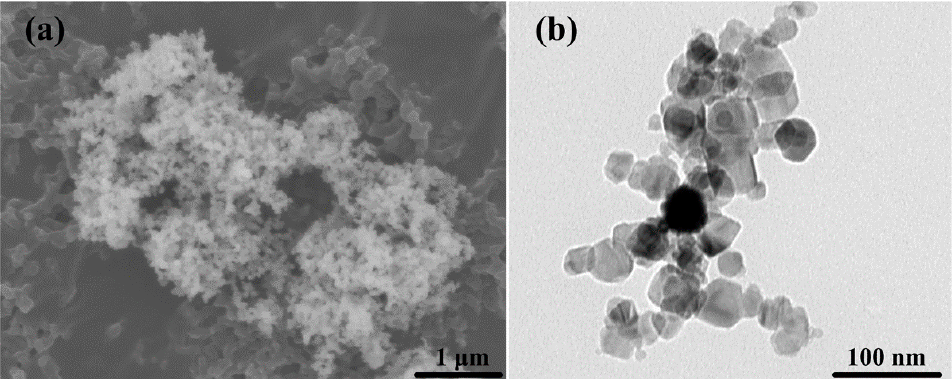
Figure 1. ( a ) FESEM micrographs; and ( b ) TEM image of nano-SiC particles.